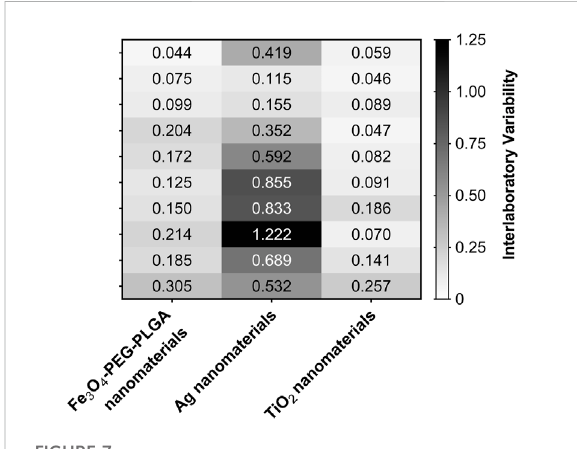
FIGURE 7 Heatmap of the interlaboratory standard deviation of the NRF2 induction results from all participating laboratories. The combinations of concentration and nanomaterials that resulted in higher variability of assay results across the partner laboratories are indicated by darker boxes in the